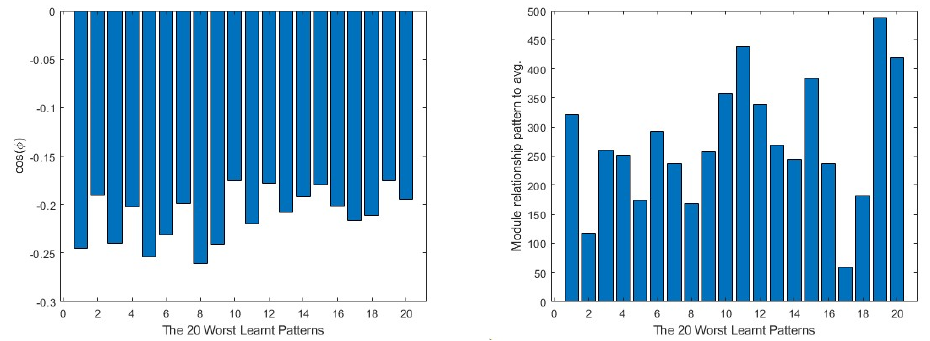
(cid:3339) (cid:4698) relationship to the av- (cid:12) (cid:12) (cid:3339) ∂ Loss µ (cid:12) (cid:12) (cid:3105)(cid:3024) (cid:3289) (cid:4698) relationship to the av- (cid:12) (cid:12) relationship to the ∂ W n (cid:3105)(cid:3024) (cid:3289)